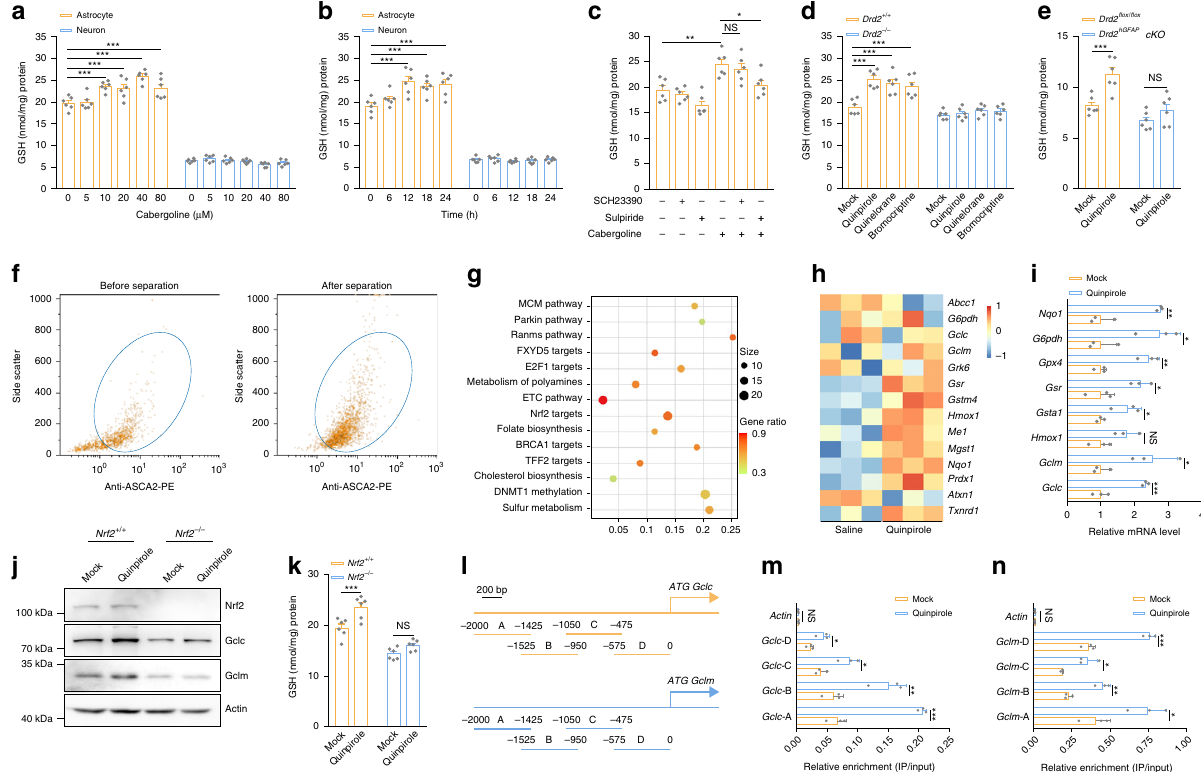
Fig. 1 Astrocytic DRD2 facilitates GSH synthesis via Nrf2 activation. a GSH levels in astrocytes and neurons after treatment with 0, 5, 10, 20, 40, or 80 µ M cabergoline for 24 h. b GSH levels in astrocytes and neurons after treatment with 10 µ M cabergoline for 6, 12, 18, or 24 h. c GSH levels in astrocytes treated with 10 μ M cabergoline for 12 h after pretreatment with SCH23390 (10 μ M) or sulpiride (10 μ M). d GSH levels in astrocytes from wild-type mice or Drd2 -knockout mice after quinpirole (10 μ M), quinelorane (20 μ M), or bromocriptine (40 μ M) treatment for 12 h. Six independent experiments per condition in a – d . e Striatal GSH levels in Drd2 fl ox/ fl ox mice and Drd2 hGFAP cKO mice after 5 mg kg − 1 quinpirole administration for 7 days. n = 6 mice per group. f Representative dot plots of ACSA-2 labeling of astrocytes (gated in blue circles) collected after microbead kit separation. g , h Gene set enrichment analysis of upregulated pathways ( g ) and heat map of the expression of Nrf2 targets (h) identi fi ed by RNA sequencing in astrocytes from mice after quinpirole administration. i Astrocytes were treated with 10 μ M quinpirole, and Nrf2 target expression was determined by qRT-PCR. Three independent experiments per condition. j , k Immunoblotting with actin as a loading control ( j ) and GSH levels ( k ) in wild-type and Nrf2 -null astrocytes after 10 μ M quinpirole treatment. Immunoblotting: three independent experiments; GSH assay: six independent experiments. l Diagram of the Gclc and Gclm promoters showing the locations of the different fragments tested. The numbers indicate the base pairs upstream of the transcriptional start site. m , n ChIP assays showing enrichment of the Gclc (m) and Gclm ( n ) promoters in DNA isolated from astrocytes treated with 10 μ M quinpirole and precipitated with anti-Nrf2 antibodies. Three independent experiments per condition. Data are presented as the mean ± s.e.m. * P < 0.05, ** P < 0.01, *** P < 0.001, NS, not signi fi cant. One-way ANOVA with Tukey ’ s multiple comparisons test ( c ), two-way ANOVA with Dunnett ’ s multiple comparisons test ( a , b and d ) or with Sidak ’ s multiple comparisons test ( e , k ), Student ’ s two-tailed unpaired t -test ( i , m and n ). Source data are provided as a Source Data fi